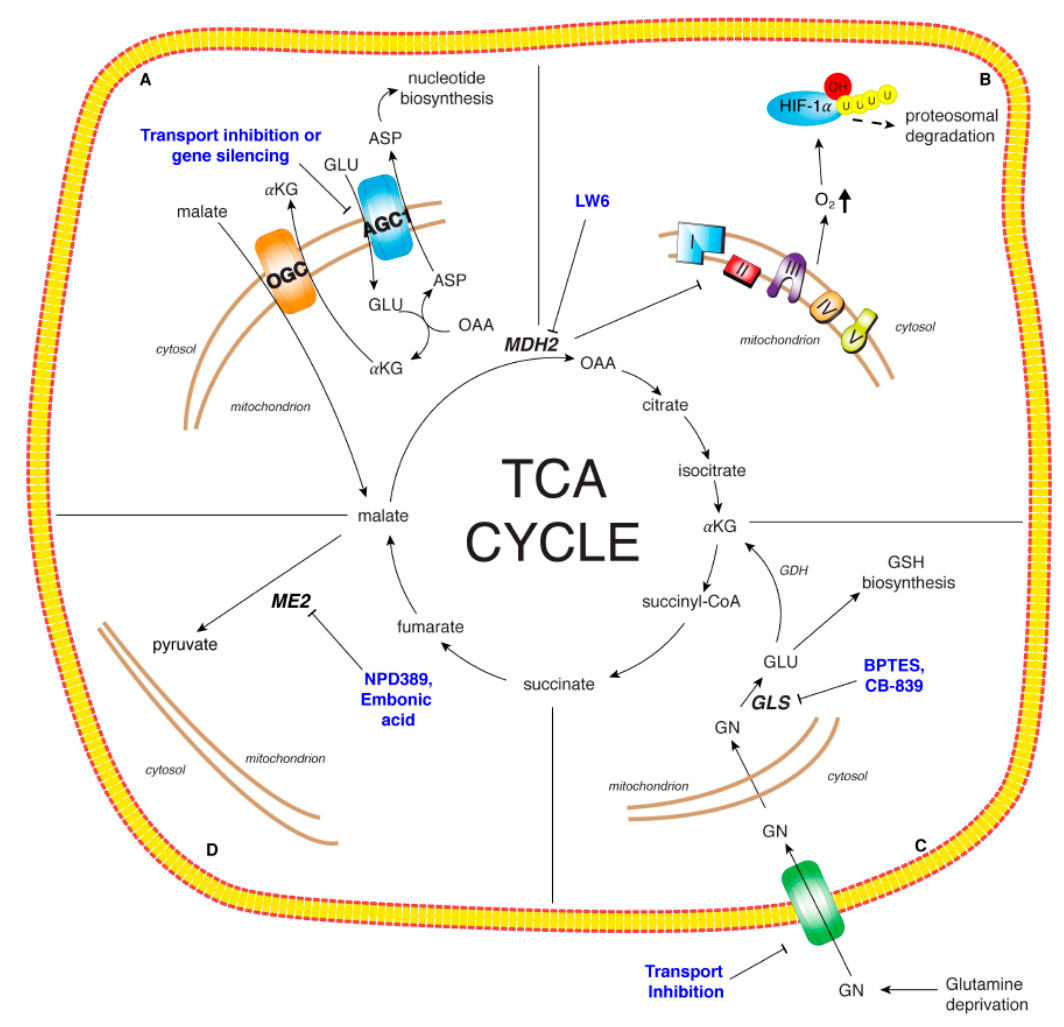
Figure 3. Therapeutic targets of TCA cycle and related enzymes. Panel A: The malate / aspartate shuttle essential for the maintenance of the REDOX state of cancer cell. The specific up-regulation of AGC1 in HCC may by targeted through gene silencing or specific protein transport inhibitors. Panel B: Malate dehydrogenase isoform 2 (MDH2): LW6, an aryloxyacetylamino benzoic acid analog, was identified as MDH2 inhibitor leading to TCA cycle impairment, mitochondrial respiration decrease and oxygen concentration increase which in turn induces HIF-1 α degradation. Panel C: Glutamine metabolism critical for cancer cell growth and proliferation. The modulation of glutamine metabolism has been proposed via glutamine deprivation, transport inhibition, reduction of glutamine metabolic enzyme activities. BPTES and CB-839 represent two promising inhibitors of GLS. Panel D: Malic enzyme isoform 2 (ME2): NPD389 and embonic acid are non-competitive inhibitors of ME2. ME2 inhibition could impair cancer cell proliferation and growth.